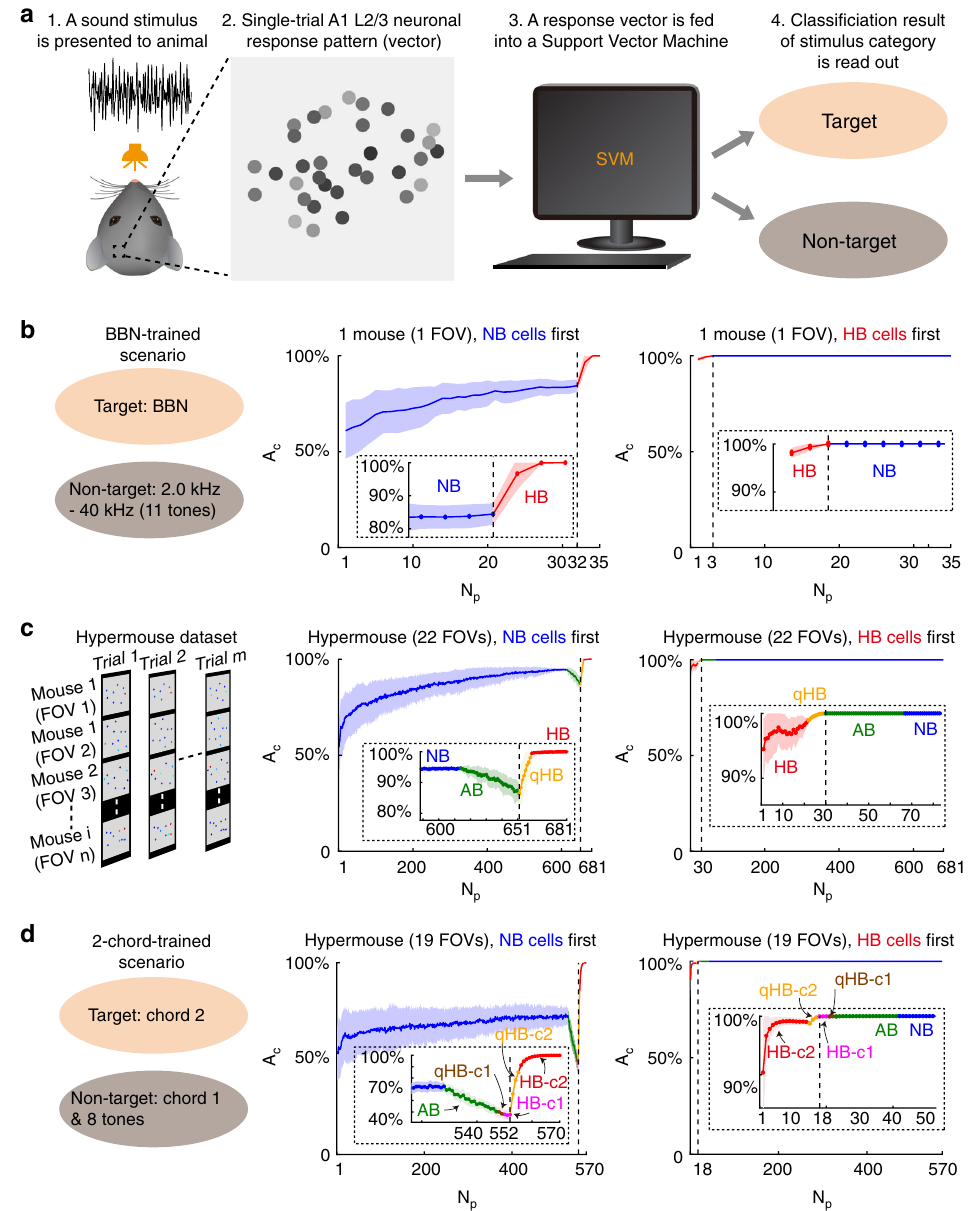
Fig. 7 Holistic/quasi-holistic bursting cells carry perfect information of trained complex sounds. a Cartoon illustration of the machine classi fi cation task. Note that in practice, the biological experiments and the machine classi fi cations were individually and sequentially performed, but the logic of information fl ow was as shown in the model. b Left cartoon: illustration of a scenario of a task with BBN-trained mice. Middle and right graphs: accuracy of classi fi cation (A c ) as a function of the neuronal population size (N p ) for one example animal. Coloured lines and shades indicate the mean and variance in the A c value corresponding to each N p value. Inset panels outlined by dashed boxes show the magni fi ed views of the A c – N p relation curve near the transition point. c Same analysis as in ( b ) performed in a hypermouse (as illustrated in the left cartoon). A neuronal response pattern of a given trial is made by concatenating the patterns of all involved FOVs of the tested mice together; patterns in each FOV for the same sound with the same chronologically ordered trial index were put together. d Same analysis as in panel c but for a different hypermouse dataset from the chord-trained animals. Shading indicates